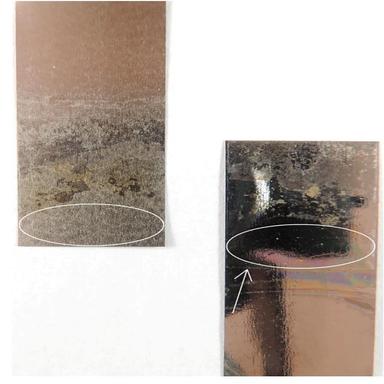
A sample consisting of two amorphous metal sheets with a two-layer binder for which the highest value of bonding strength was noted.